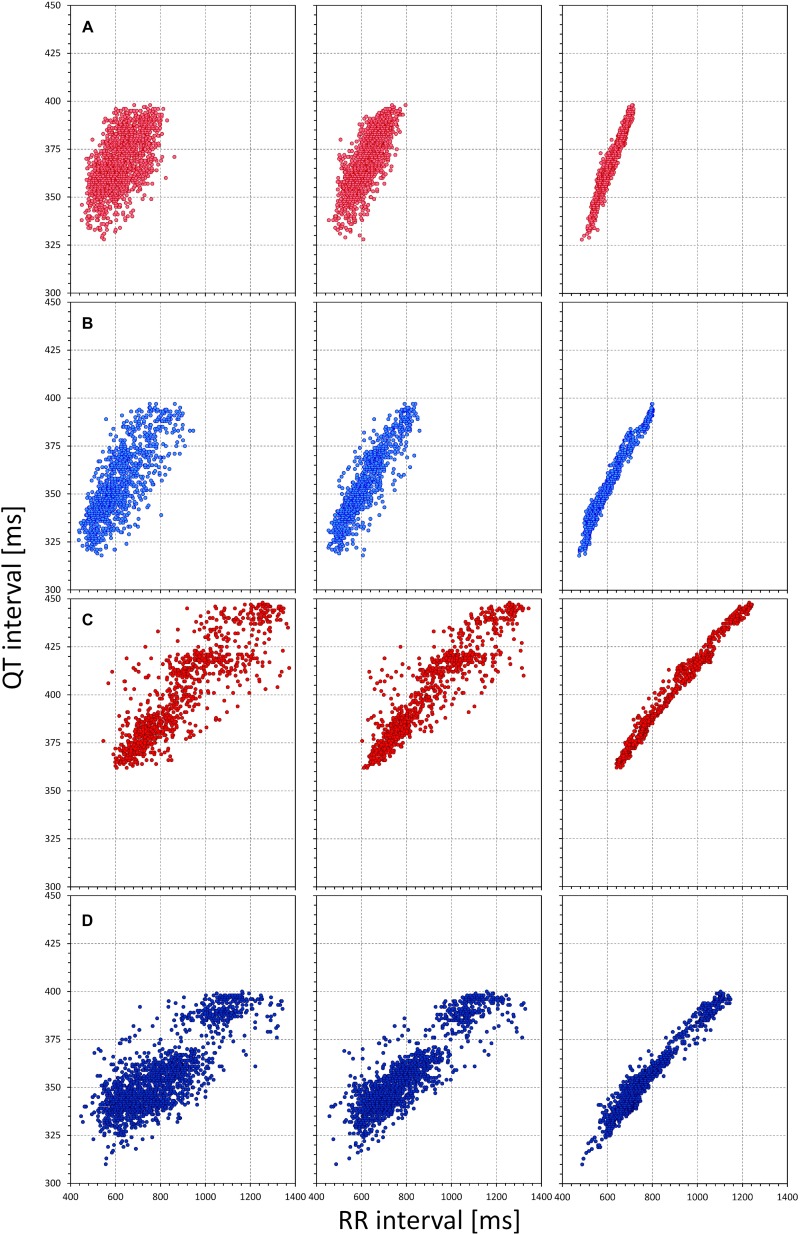
The figure shows examples of comparisons of QT/RR relationship using different RR interval expressions. Each row of panels corresponds to one subject. In each subject, the QT interval measurements are the same but the panels on the left relate the QT intervals to the averages of three RR intervals, the panels in the middle to 10-s RR interval averages, and the panels of the right to the RR interval values obtained from the 5-min histories of the QT interval measurements by individual QT/RR hysteresis profiles. Note the increase of the regression fit from the left panels to the right panels. Cases (A–D) correspond to a female aged 7.4 years, a male aged 7.7 years, a female aged 18.7 years, and a male aged 18.7 years, respectively.